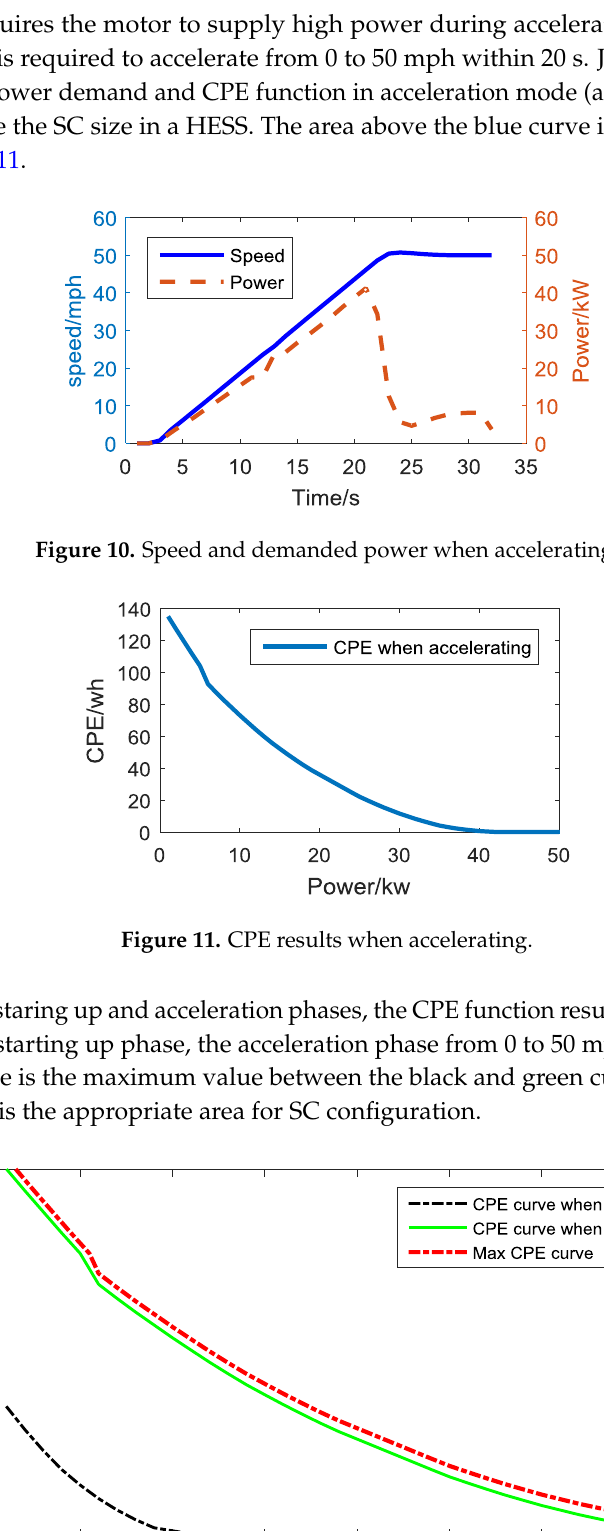
Figure 12. CPE curves in special phases.